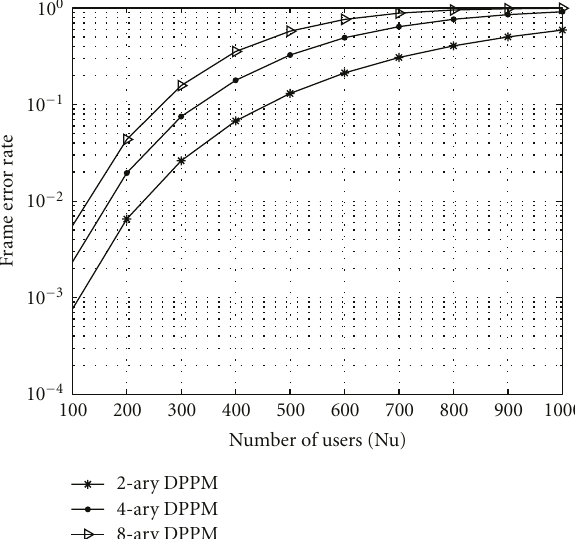
Figure 6: Relationship between frame error rate and number of users for M -ary DPPM with receive diversity L d = 4, and a frame length of 128bits over an AWGN channel, β = 500, SNR =